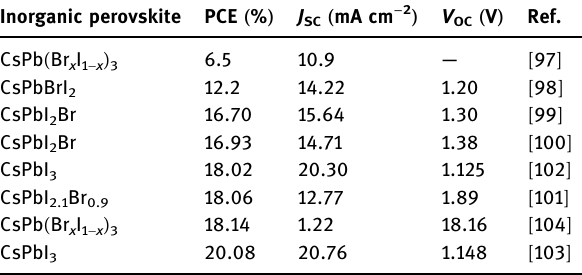
Table 1: PV parameters of the inorganic perovskite - based solar cells Inorganic perovskite PCE ( % ) J SC ( mA cm − 2 ) V OC ( V )